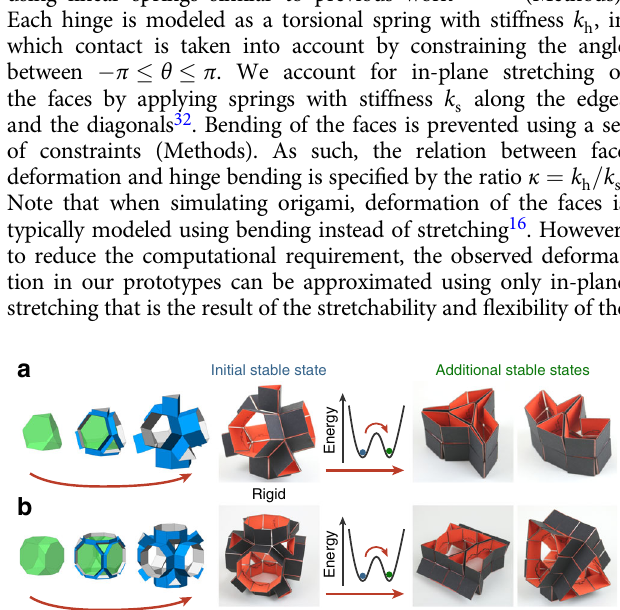
using linear springs similar to previous work 16,17,32 (Methods).